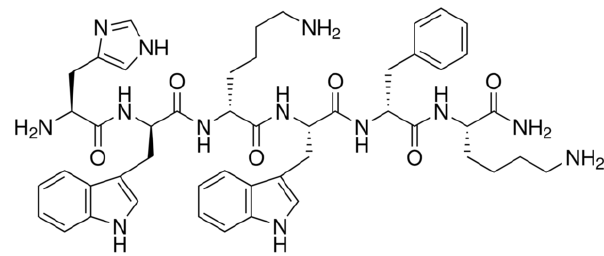
Figure 1. Chemical structure of [D-Lys 3 ]-GHRP-6.